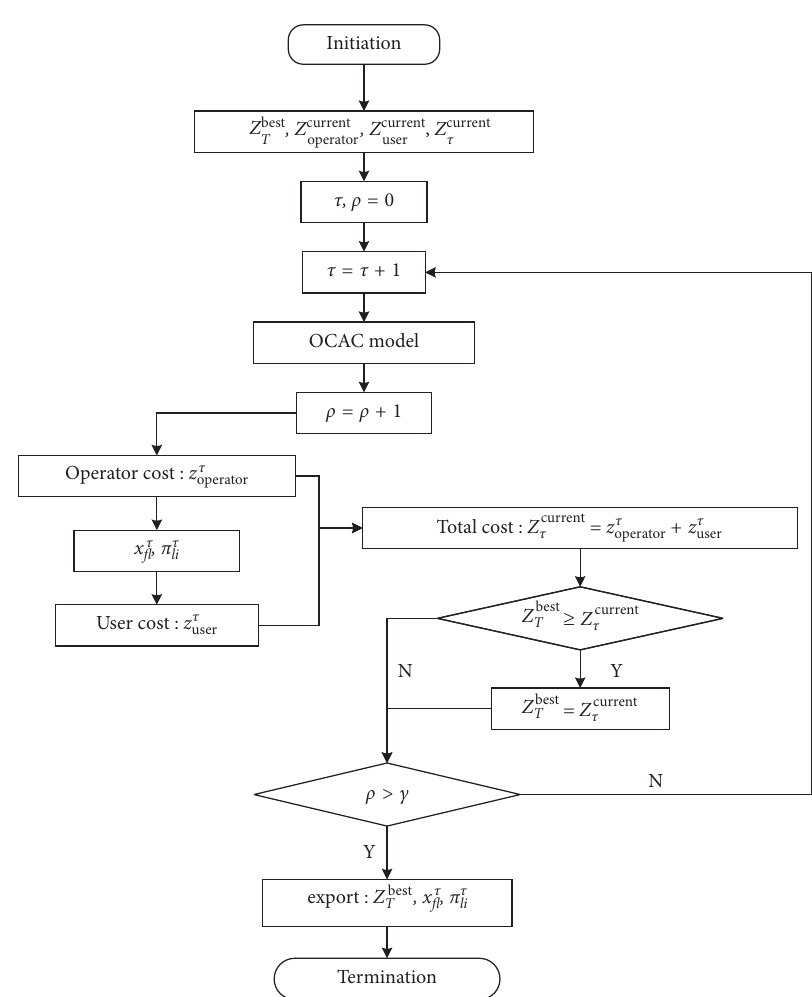
Figure 4: Flowchart of the search